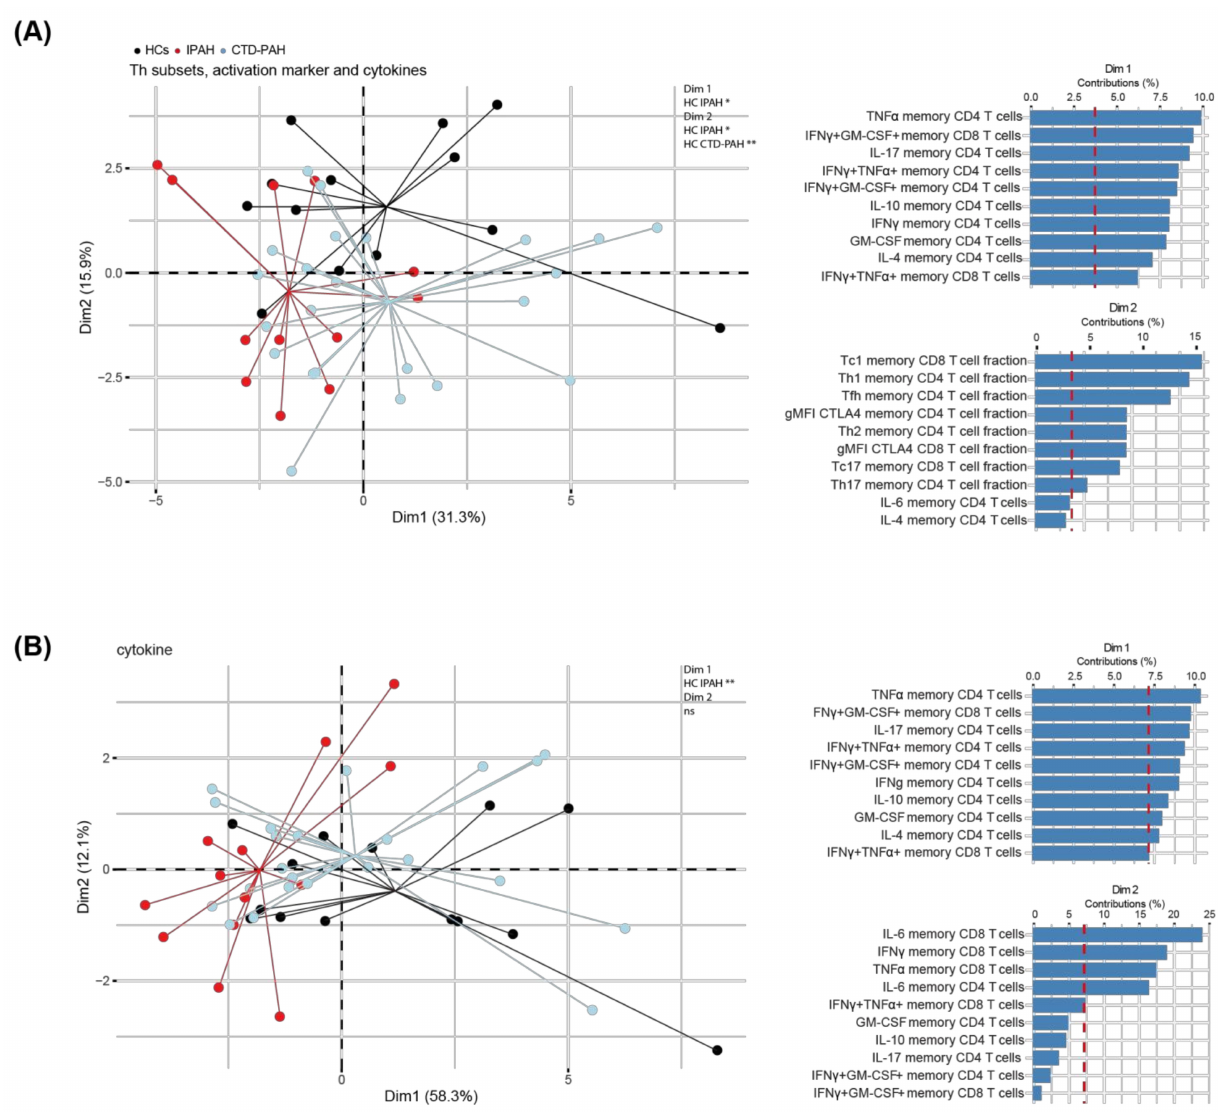
Figure 3. Multivariate analysis separates treatment-naive PAH patients from HCs, mainly by T cell cytokine production. ( A ) Principal component analysis (PCA) of HCs ( n = 13), IPAH ( n = 12) and CTD-PAH ( n = 23) patients of whom all variables (peripheral T cell subsets, activation markers and cytokine production) could be determined by flow cytometry ( left ), with the contributions of the top 10 variables in percentages of Dim1 and Dim2 ( right ). ( B ) PCA of T cell cytokines only of HCs ( n = 14), IPAH ( n = 13) and CTD-PAH ( n = 23) patients determined by flow cytometry and contributions of the top 10 variables in percentages of Dim1 and Dim2. Symbols represent values of individual patients or HCs, whereby lines connect these values to the mean Dim1 and Dim2 coordinates. Mann–Whitney U test was used for statistical analysis of coordinates on the dimension between PAH patients and HCs, * p < 0.05, ** p <